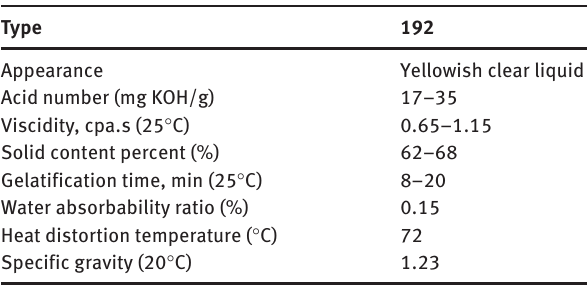
Table 1 Performance parameters of 192 unsaturated polyester resin.